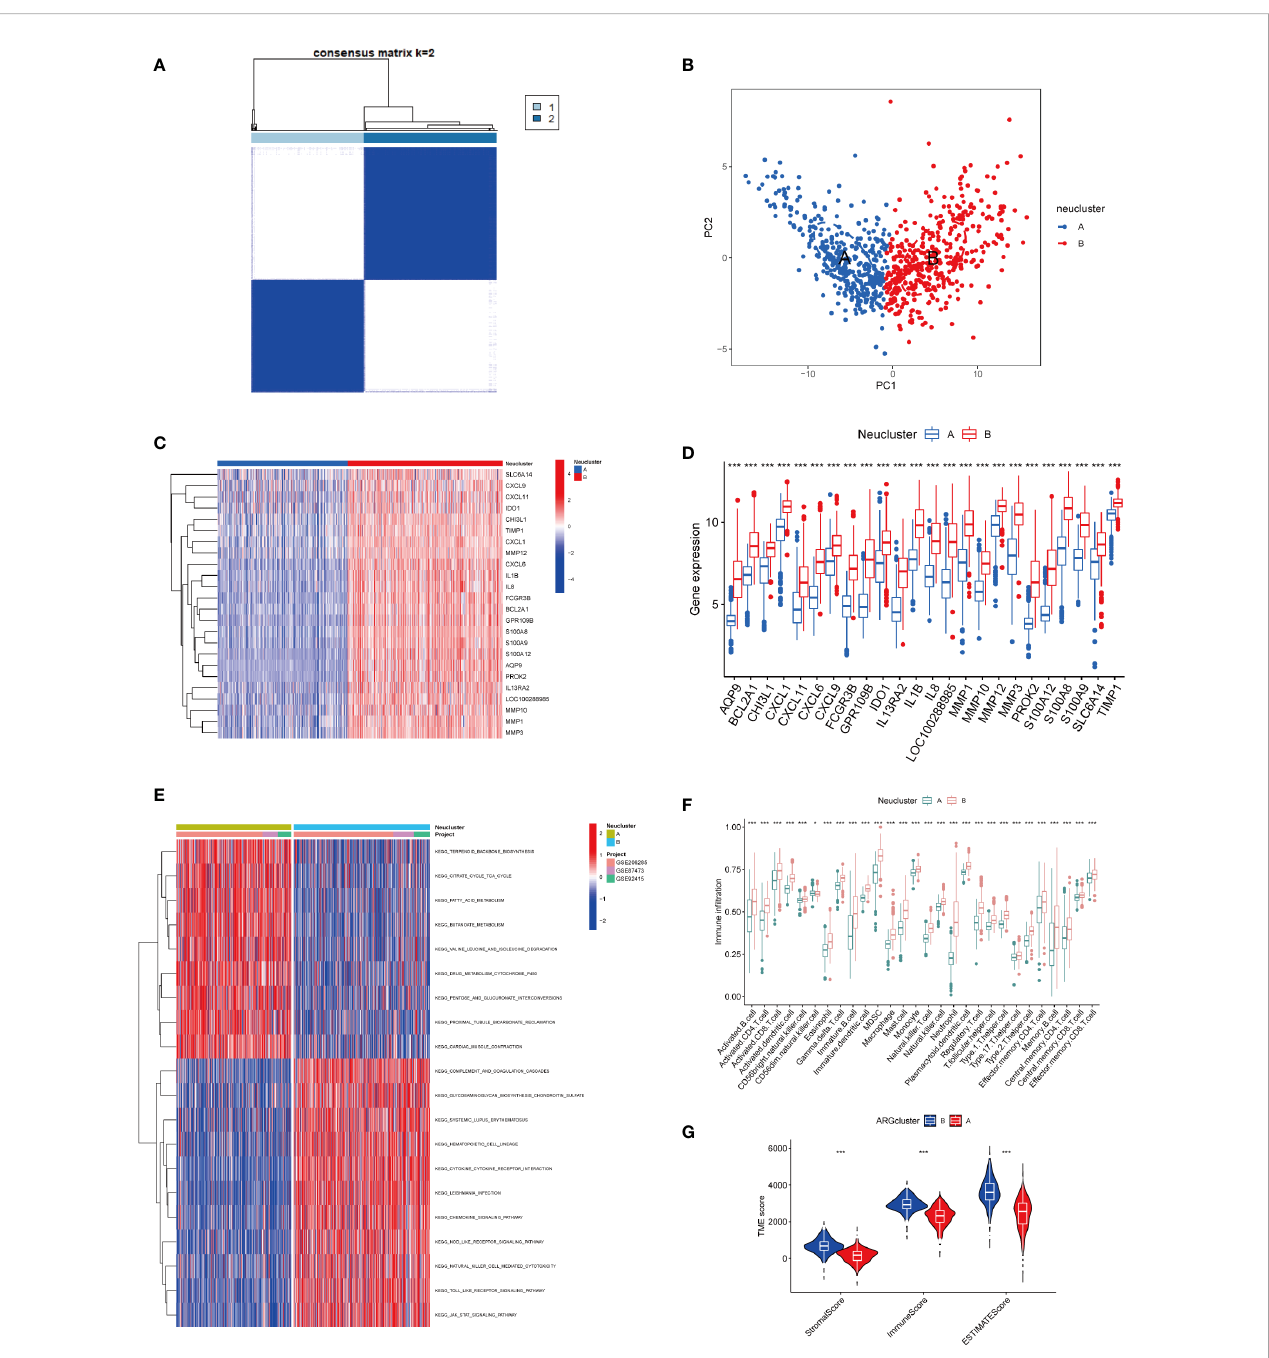
FIGURE 3 Exploration of neutrophil-associated subtypes and biological features. (A) Consensus matrix heatmap de fi ning two clusters (k = 2) and their correlation area. (B) PCA analysis showed signi fi cant differences in transcriptomes between the two subtypes. (C, D) Heatmap and boxplot of the expression of 24 NADEGs in different clusters. Red for upper regulation, blue for lower regulation. (E) GSVA of biological pathways between two distinct subtypes, in which red represented activated and blue inhibited pathways. (F) The ssGESA results indicated the abundance of 28 in fi ltrating immune cells in different subtypes. The asterisks represented the statistical P-value (*P < 0.05; **P < 0.01; ***P < 0.001). (G) Correlations between the two subtypes and TME score. The asterisks represented the statistical P-value (*P < 0.05; **P < 0.01; ***P <